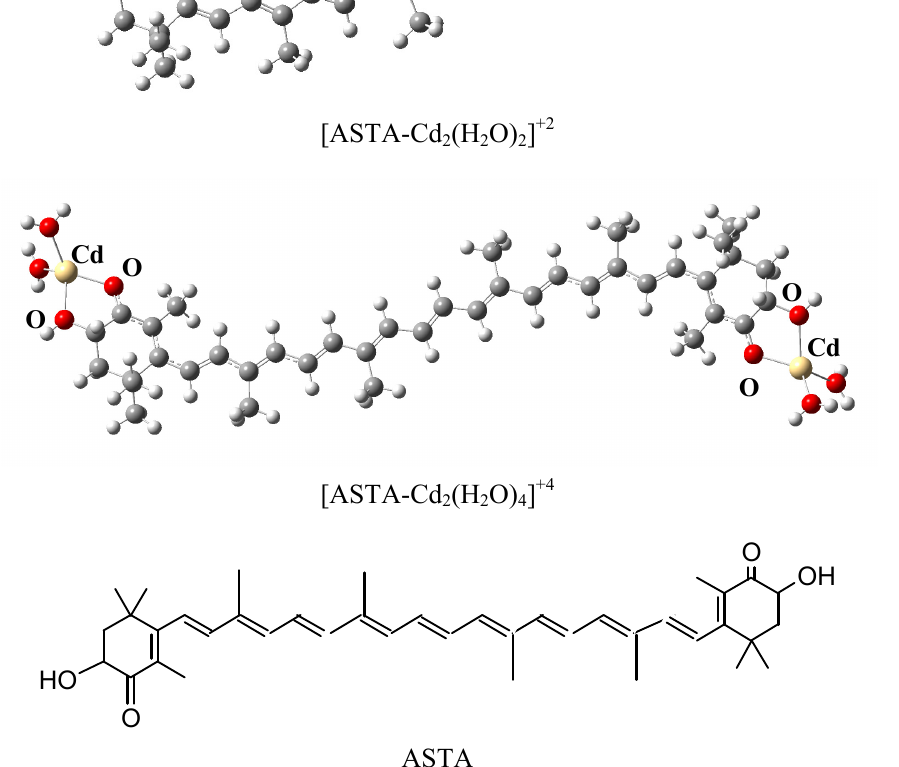
(H O) ] +4 . Schematic representation of ASTA is also 2 2 4